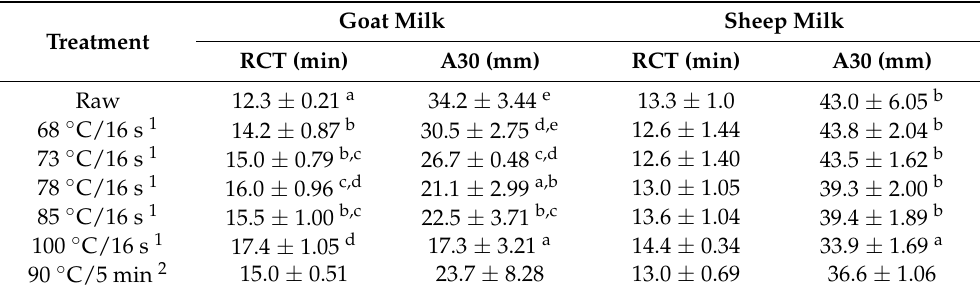
Table 3. Rennet clotting behavior of heat-treated goat and sheep milk; means ± standard deviation. RCT, rennet clotting time; A30, curd firmness. Different letters indicate significant differences (LSD, p < 0.05) between the means of different heat treatments. Goat Milk Sheep Milk Treatment RCT (min) A30 (mm) RCT